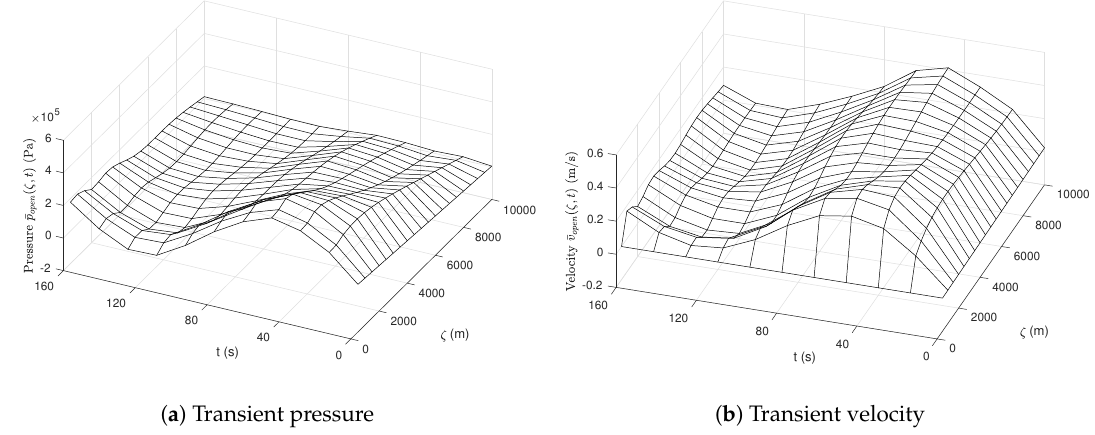
Figure 3. State evolution of the noise-free water hammer system.